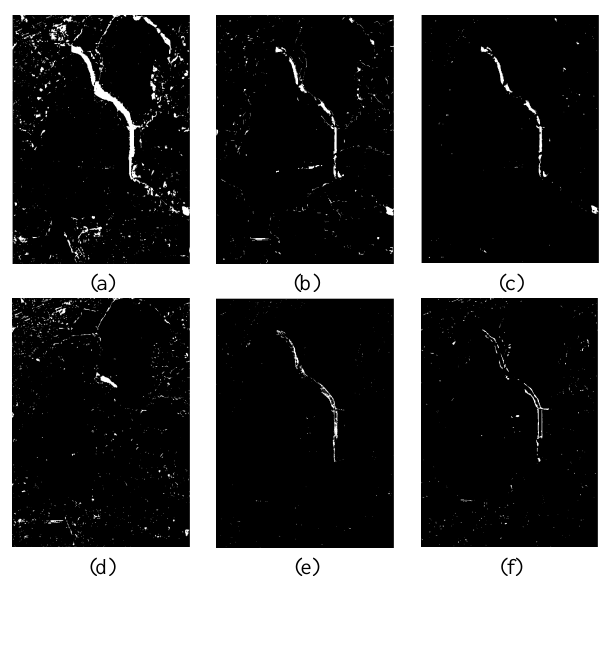
Figure 3. RADARSAT-2 PolSAR images acquired on (a) December 07, 2011. (b) June 25, 2015. (c) July 6, 2016; and GF-3 PolSAR images acquired on (d) April, 30, 2017. (e) May, 29, 2017. The validity of the proposed algorithm applied to different sensors is verified in this part. OS_GMM method was used to detect the change in the construction process of East Lake Tunnel. Dramatic changes have taken place around East Lake from 2011 to 2017 and the changes of different period over East Lake are shown in Figure 4.